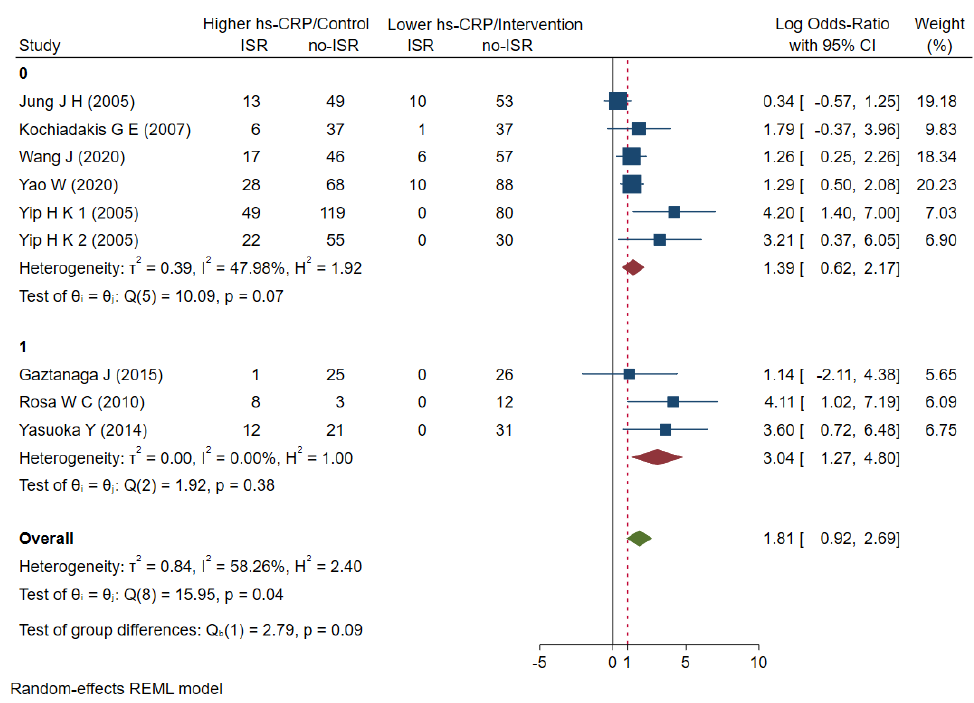
Figure 5. Meta-analysis of ORs in studies evaluating the prognostic value of hs-CRP to restenosis in higher vs lower hs-CRP group as sub-grouped by age. OR: odds ratio, hs-CRP: high-sensitive C-reactive protein, ISR: in-stent restenosis, 0: < 60(years), 1: ≥60(years) [21–29].